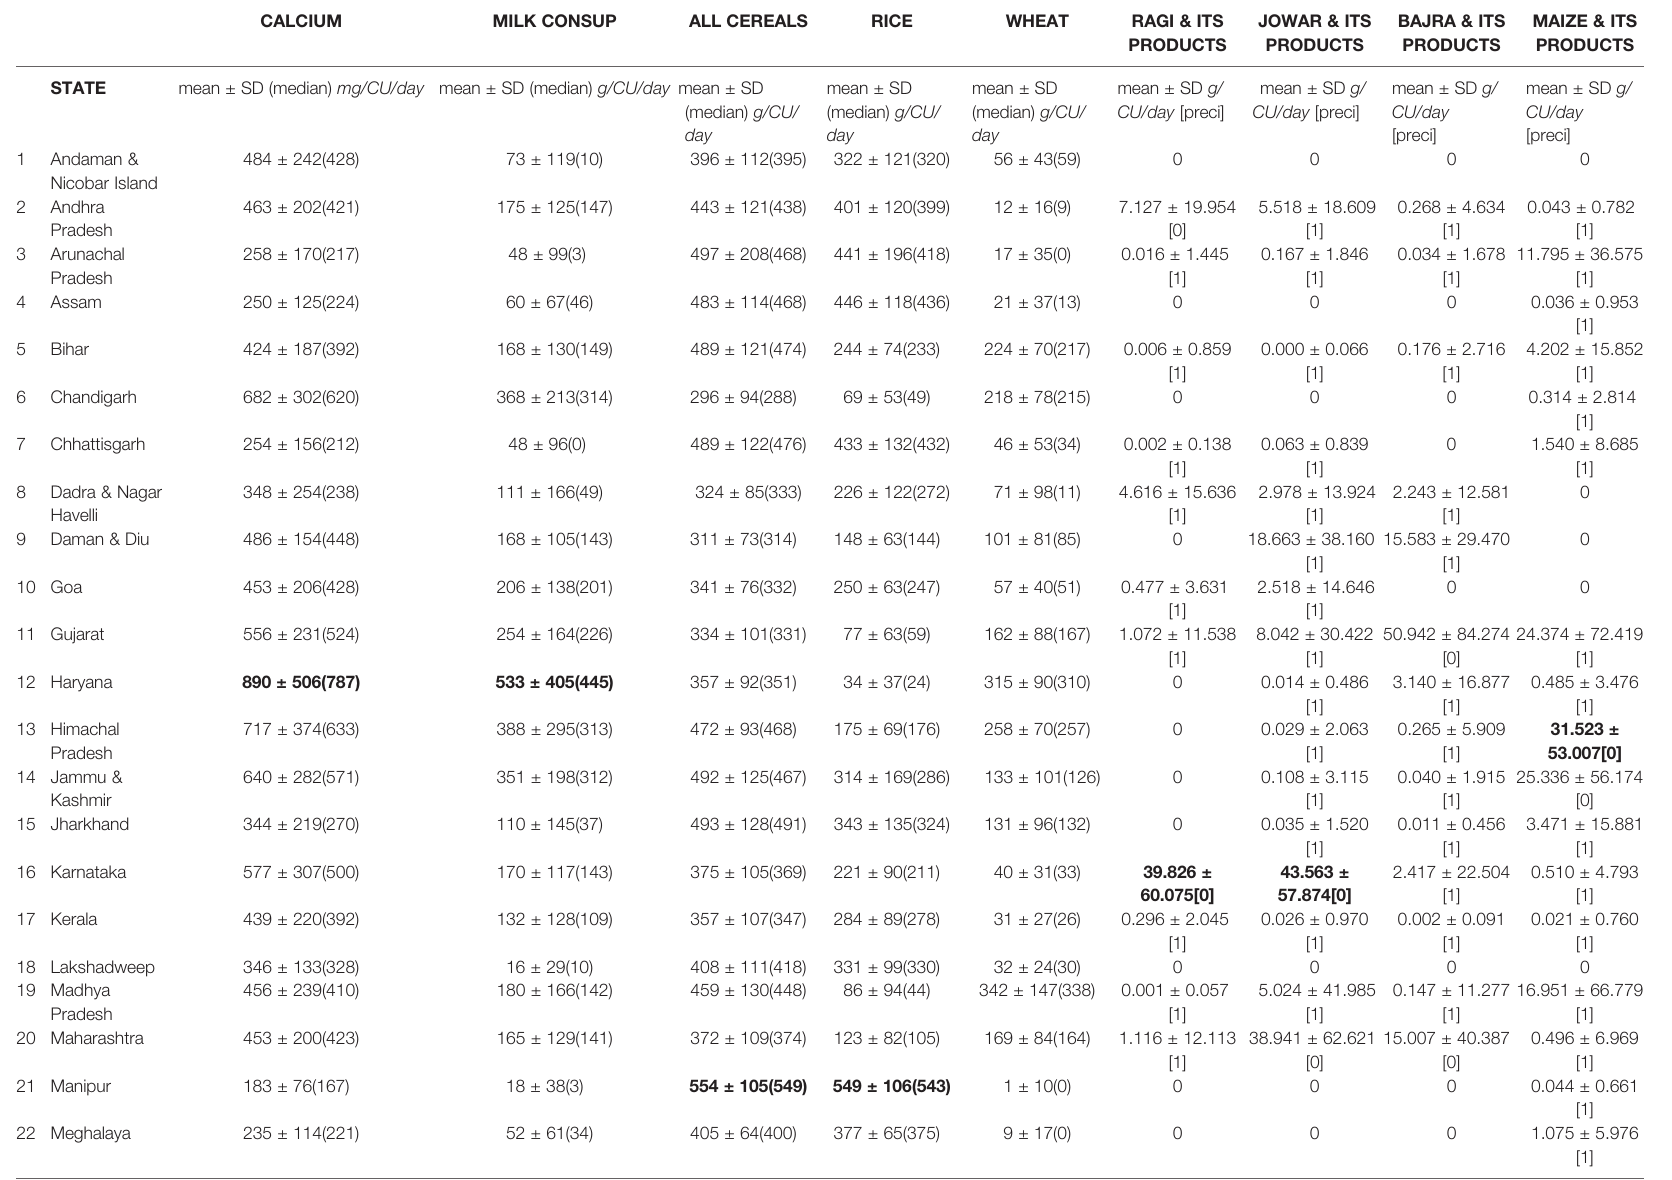
TABLE 3 | (104, 105) The daily intake of various food categories in grams per capita per day and nutrients in grams per consumer unit in different states in India[Precision is > 0.05 happens due to low coverage/ sample size or high coef fi cient of variation (SD/Mean) or